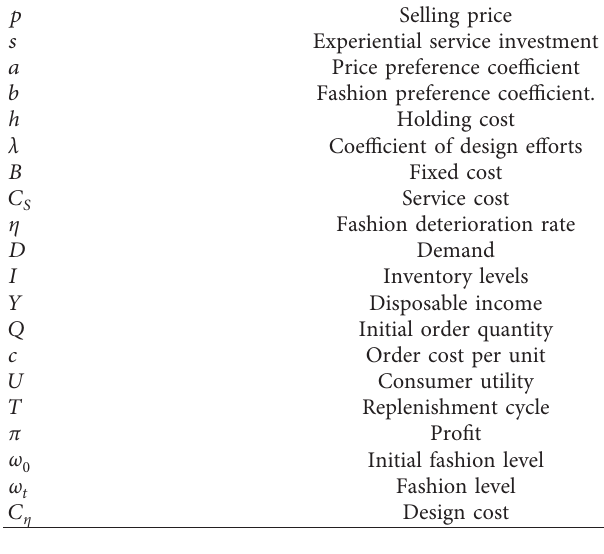
Table 1: Notations and